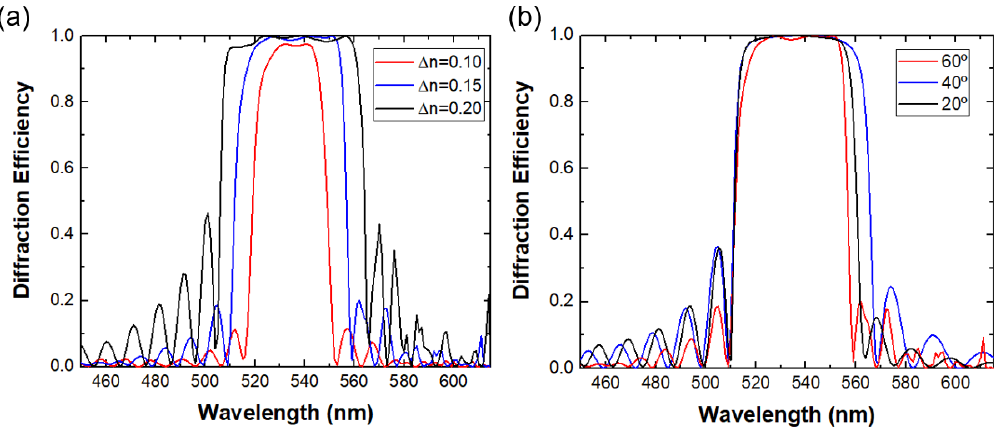
Figure 3. Wavelength response of PVGs. The horizontal period ( P x ) is 440 nm, vertical period ( P z ) is 205 nm, and the central wavelength is 532 nm. ( a ) Diffraction efficiency spectra at normal incidence and 50° diffraction angle with different refractive index contrast and ( b ) different diffraction angles with Δ n = 0.15.